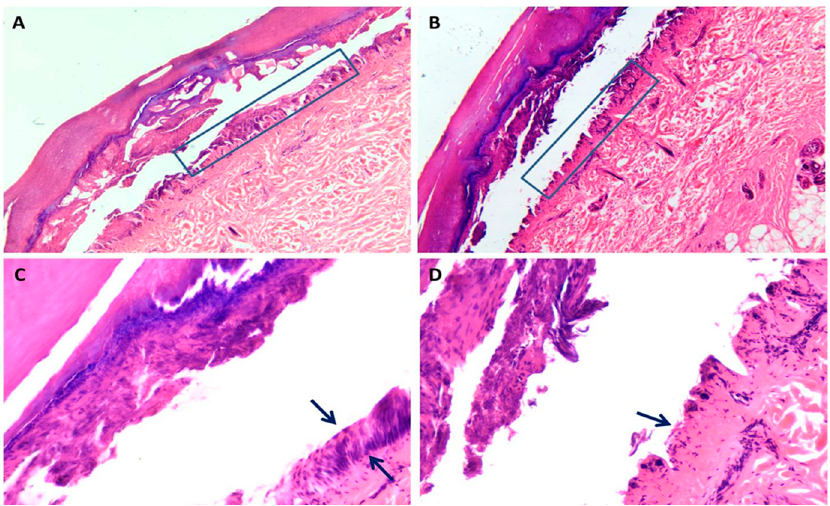
Figure 1. Macroscopic findings. Electrical lesions on the right palm ( A insert) from low voltage; electric lesion of the dorsal face of the second finger on the left hand from high voltage ( B ).